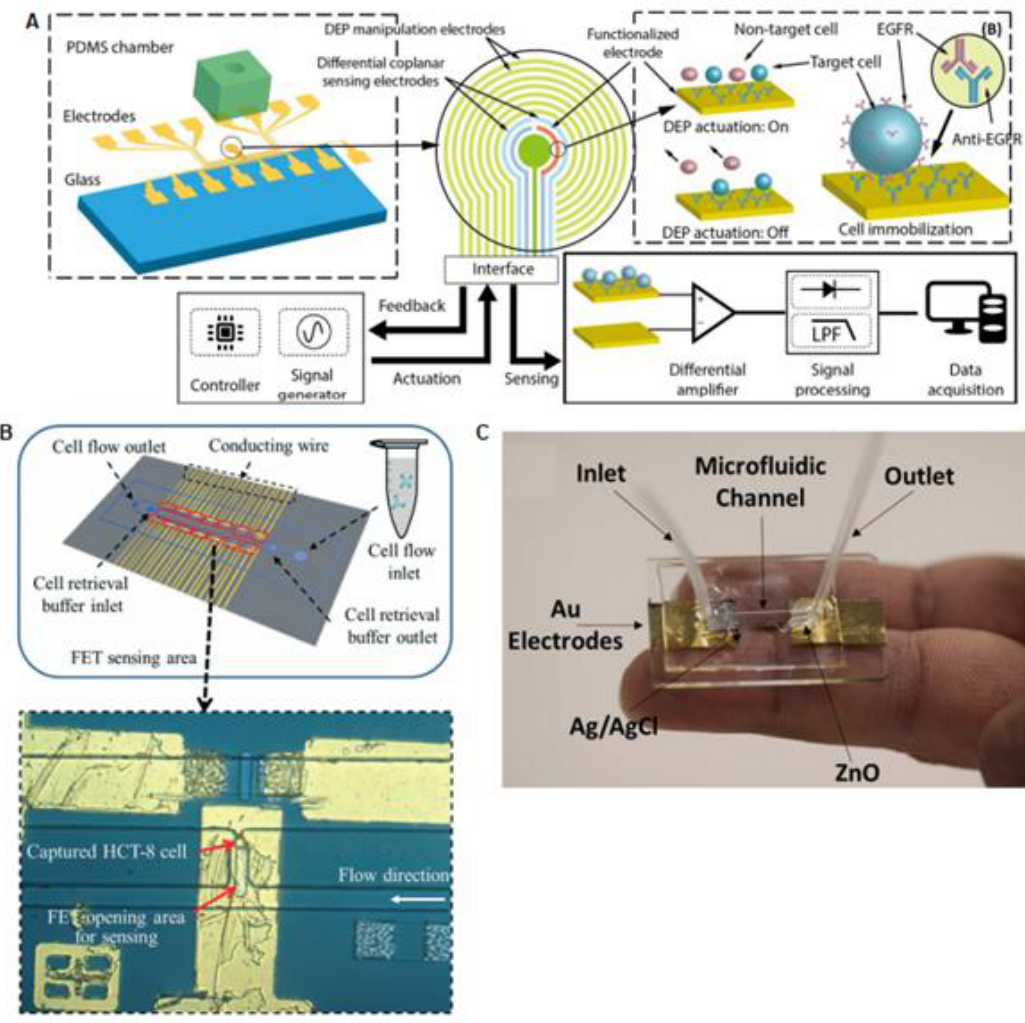
Figure 3. ( A ) Diagram of dielectrophoresis microfluidic platform composed by a chamber made of PDMS and a capacitive sensor for circulating tumor cell detection. Thus, tumor cells are separated by DEP and a stepping electric field [65]; Copyright © 2018. The Korean BioChip Society and Springer-Verlag GmbH Germany, part of Springer Nature. ( B ) Integrated microfluidic platform is composed of a microfluidic device and a collection of FET-sensors inserted in epoxy substrate, able to capture cancer cells on the transistor sensing surface [59]; republished with permission of [Royal Society of Chemistry]; permission conveyedthroughCopyrightClearanceCenter, Inc. ( C )MicrofluidicpHSensorbasedonthemeasurements between a silver–silver chloride and zinc oxide electrodes for CTCs recognition in blood. The device detects the cancer cells based on changes of pH in the extracellular environment [64]; Copyright © 2017, American Chemical